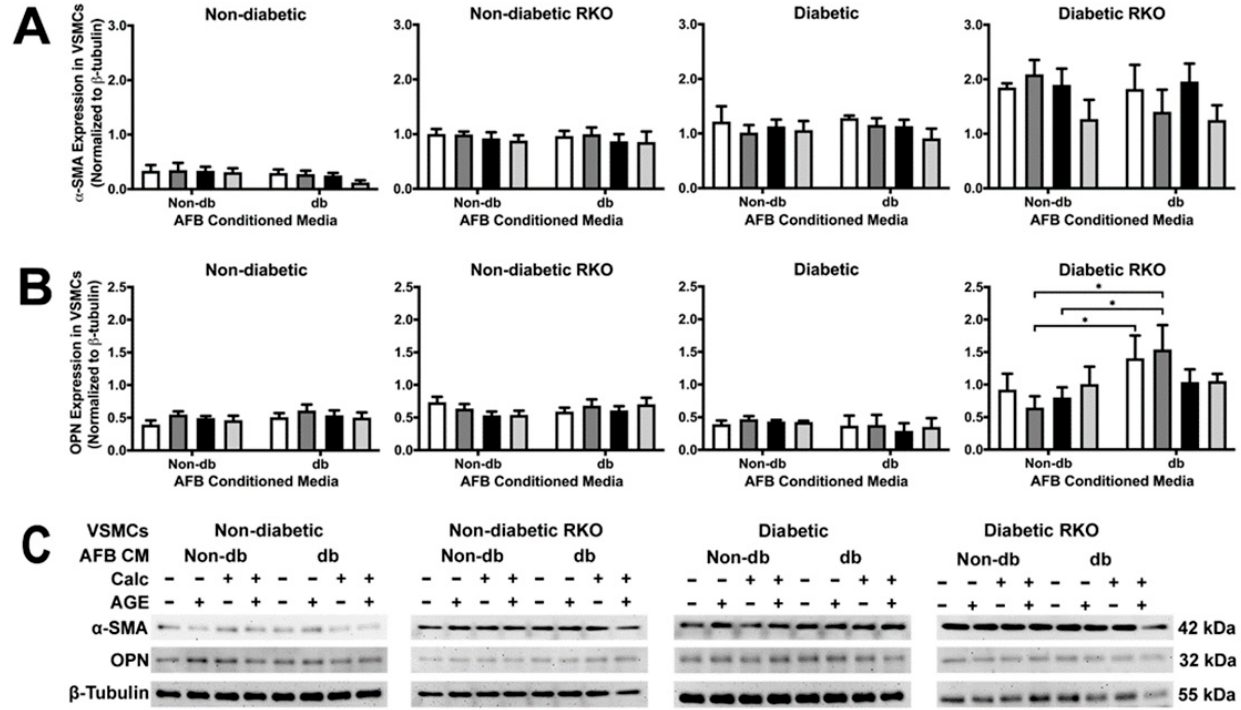
Figure 2. Diabetic RKO VSMCs had more α -SMA and OPN expression than other genotypes while diabetic RKO cells showed an increase in OPN due to diabetic AFBs-conditioned media application. Primary VSMCs were isolated and treated with AFBs-conditioned media at a 1:10 dilution in 2% FBS genotype appropriate DMEM for 7 days. Protein expression was quantified of α -SMA (42 kDa: ( A )) and OPN (32 kDa: ( B )). All protein levels were normalized to β -tubulin ( C ) and graphed as mean ± SEM with n = 3–6 of independent replicates. A two-way ANOVA with Fisher’s LSD post hoc was performed (* p < 0.05) on each graph individually. All data were analyzed together with a two-way ANOVA to give the following: α -SMA (Interaction; p = 0.7660, Genotype; p < 0.0001, and Treatment; p = 0.1193) and OPN ((Interaction; p = 0.7430, Genotype; p < 0.0001, and Treatment; p = 0.4289).